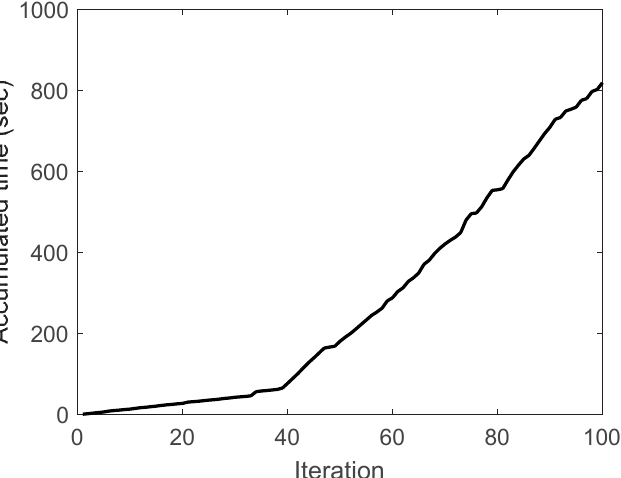
Figure 7. Accumulated optimization algorithm time for the method of moving asymptotes (MMA).